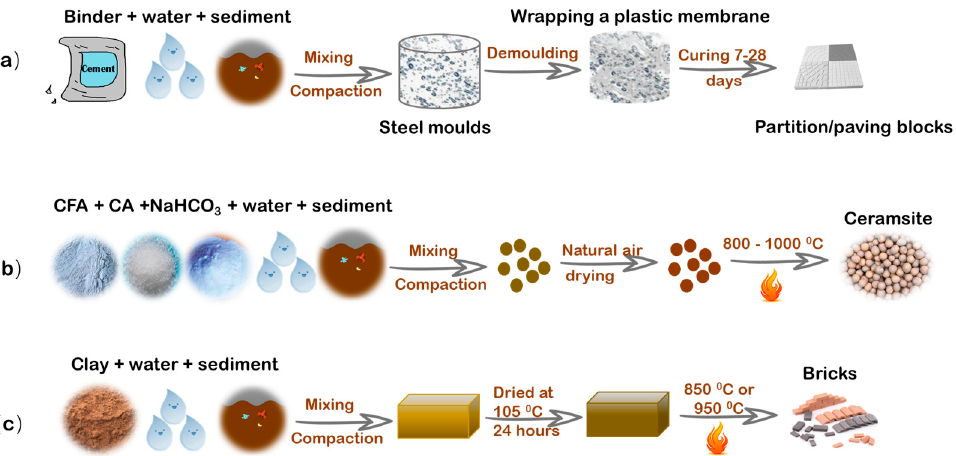
Figure 2. Possible processing stages of partition/paving blocks ( a ) ceramsite ( b ) and bricks ( c ) (This picture is reproduced according to [95,97,150,153]).